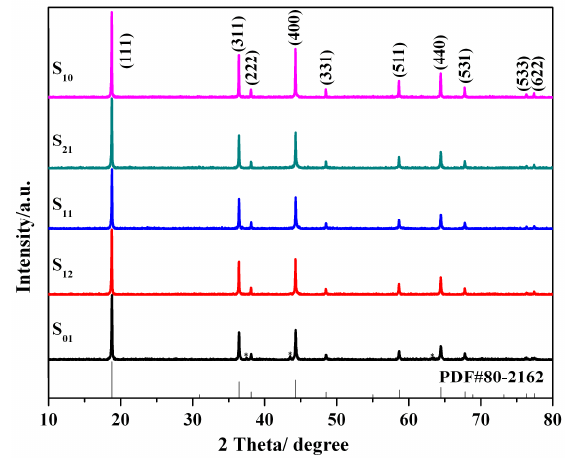
Figure 2. XRD patterns of LNMO samples prepared by mixed precipitants of (NH 4 ) 2 CO 3 and Na 2 CO 3 with different molar ratios. Table 1. The structural parameters for the LNMO samples prepared by mixed precipitants of (NH 4 ) 2 CO 3 and Na 2 CO 3 with different molar ratios.